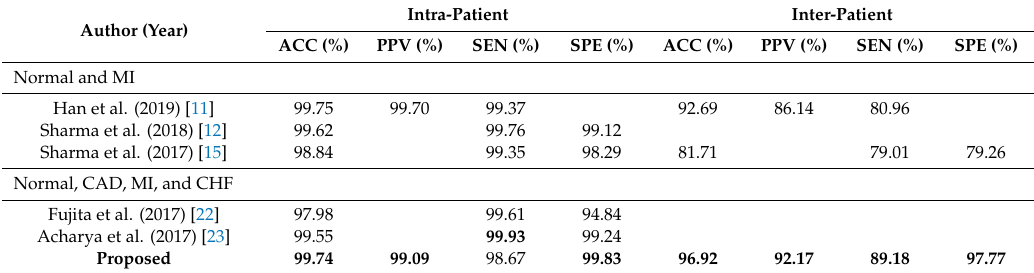
Table 15. Comparison of the proposed model against the recent literatures using the same databases. Author